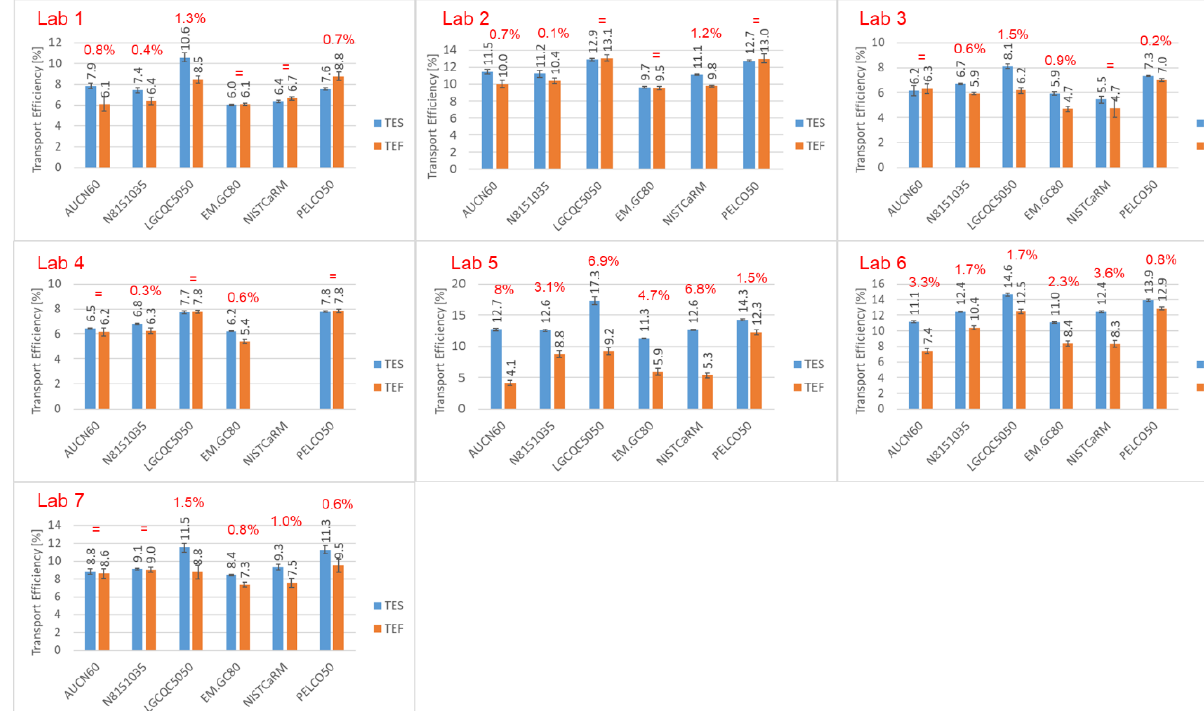
Figure 8. Transport efficiencies obtained based on measured particle frequency and particle size as an average of all three/four days of measurement. The red percentages at the top of the bars represent the absolute differences between the two approaches considering the lower and upper uncertainty bounds. Significant correlations between TES and TEF are shown in Figure S11 (SM11).